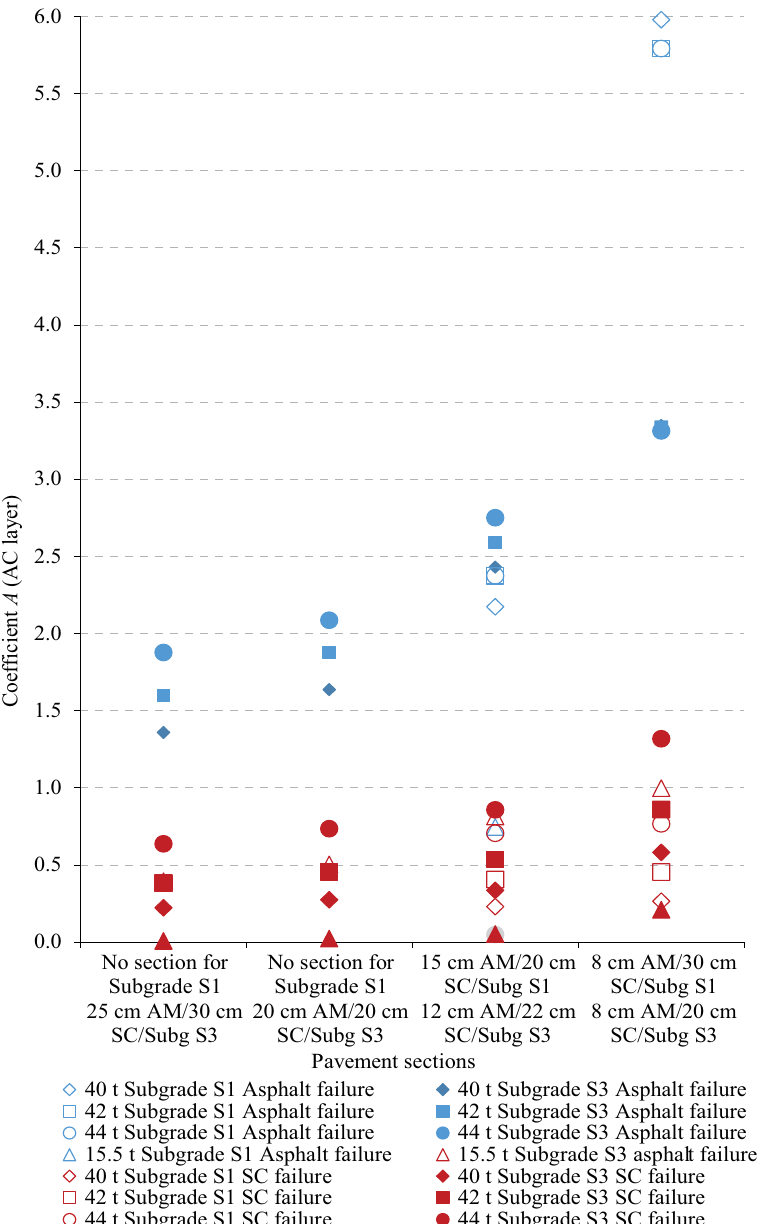
Figure 4. Aggressiveness coefficient for a heavy vehicle on semi-rigid